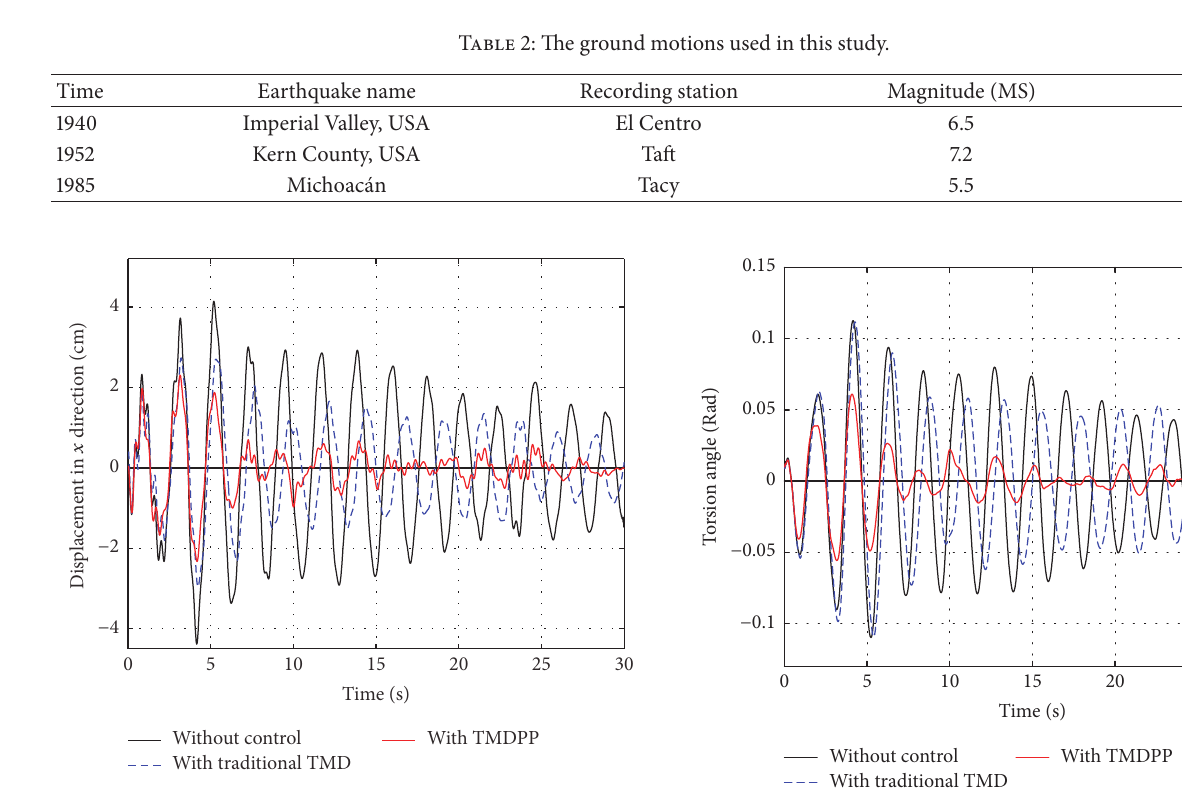
Figure 7: Damping comparison of structural displacement in 𝑥 direction.